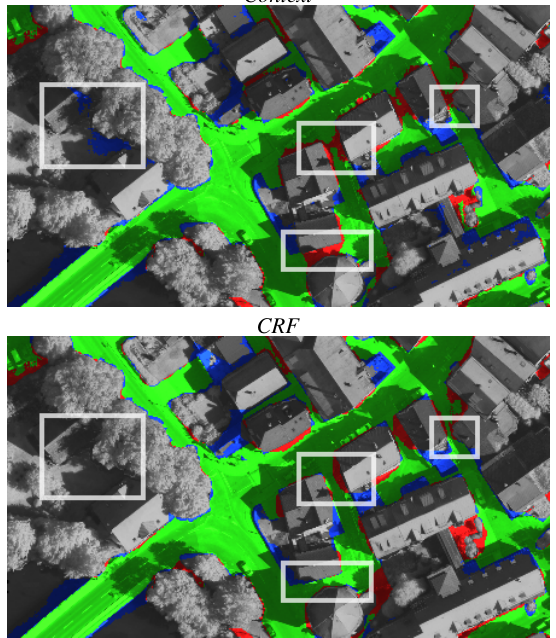
Figure 6. Example of extracted roads. True positives are dis- played green, false positives blue, and false negatives red. White frames highlight significant